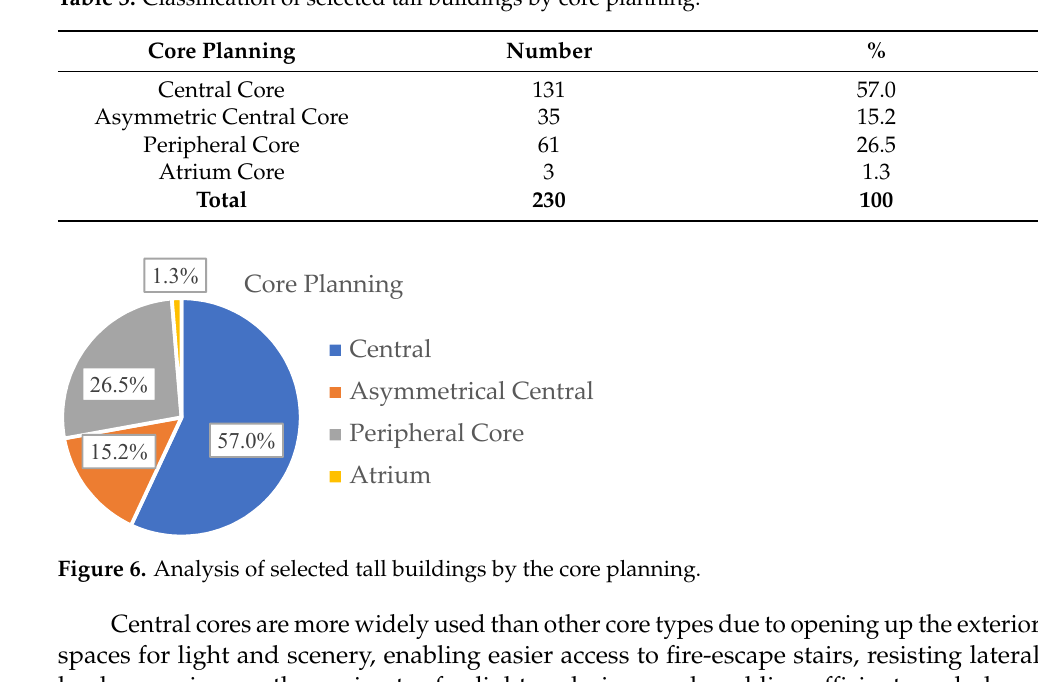
Figure 5. Core arrangement classification for tall buildings.